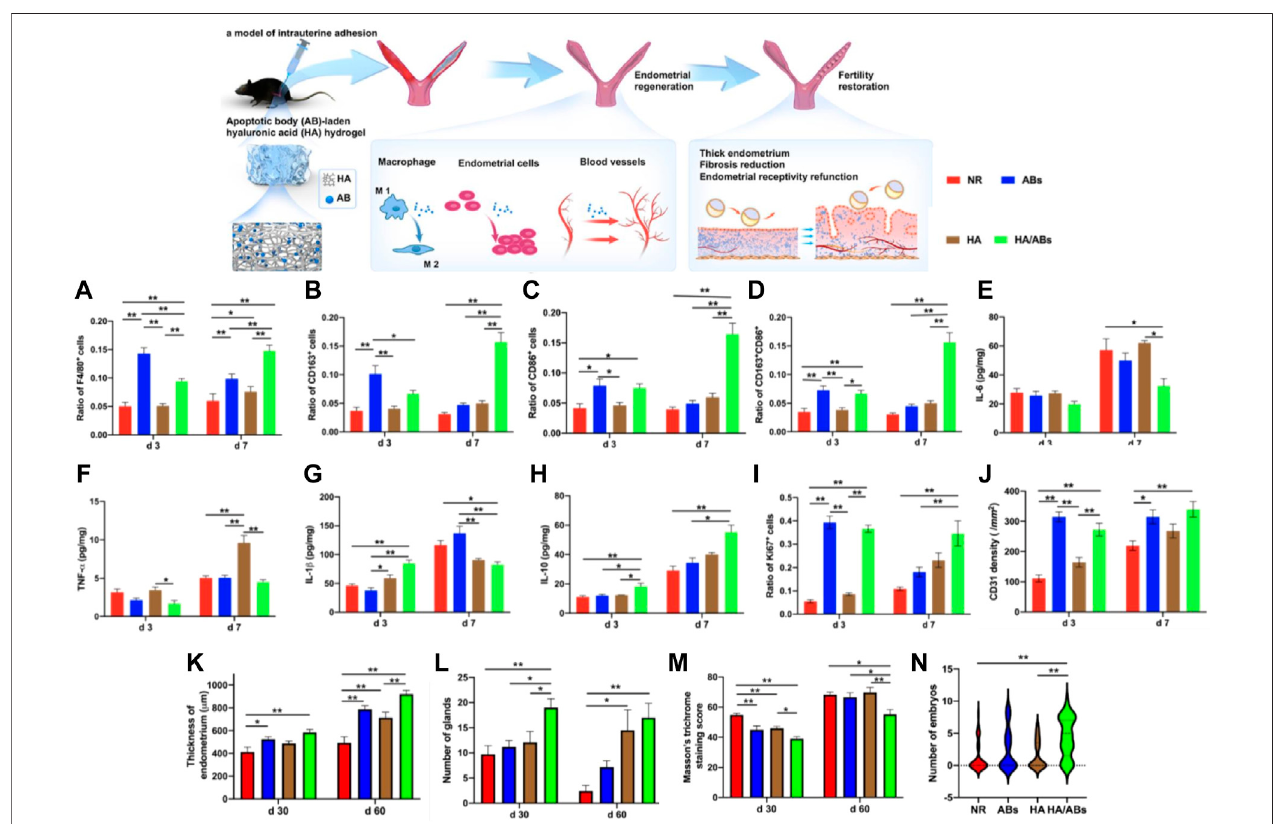
FIGURE3| Anapoptotic body (A,B) -laden hyaluronicacid(HA) hydrogel wasdesigned todeliverABs in situ totreat IUAinarodentmodel. Statistical analysiswas performed to examine the expressions of F4/80 (A) (marker of macrophages), CD163 (B) (marker of M2 macrophages), CD86 (C) (marker of M1 macrophages) and concurrent expression of CD163 and CD86 (D) (n =8). ELISAfor IL-6 (E) , TNF- α (F) ,IL-1 β (G) and IL-10 (H) in uteri under different treatments (n =4). Statistical analysis wasperformed toexaminethe expressionsof Ki67 (e) (markerassociated with cell proliferation) and CD31 (f)(marker ofcapillary vessels) (n =8).The results in a-d, (I,J) werenormalizedtothetotalnumberofcellsperviewundera×400magni fi cationandexpressedasaratioofthetotalnumberofcellspositiveforamarkertothetotal number of cells present. (K) Quanti fi cation ofendometrial thickness at days 30 and 60 post-surgery using H&E staining (n= 10). (L) Quanti fi cation of endometrial glands at days 30 and 60 post-surgery using H&E staining (n = 10). (M) Masson ’ s trichrome staining scores for uteri at days 30 and 60 after treatment (n = 10). (N) Violin plots showing the number of embryos per uterine horn following different treatments (n = 33 in the NR and ABs groups, n = 29 in the HA and HA/ABs groups). NR,